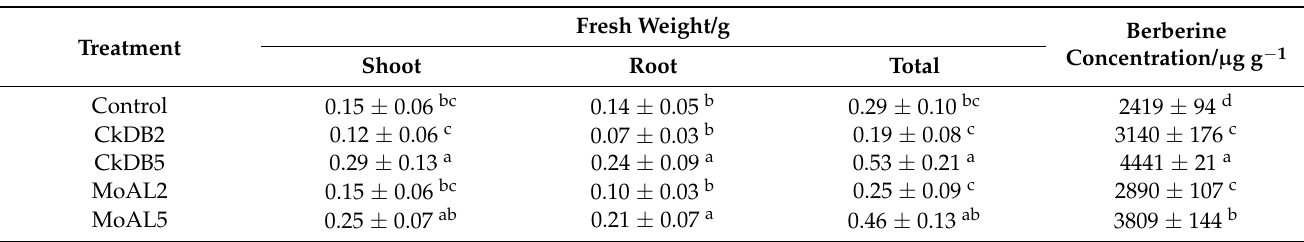
Table 1. Growth and berberine concentrations in M. oiwakensis seedlings inoculated with different fungal isolates after three months of